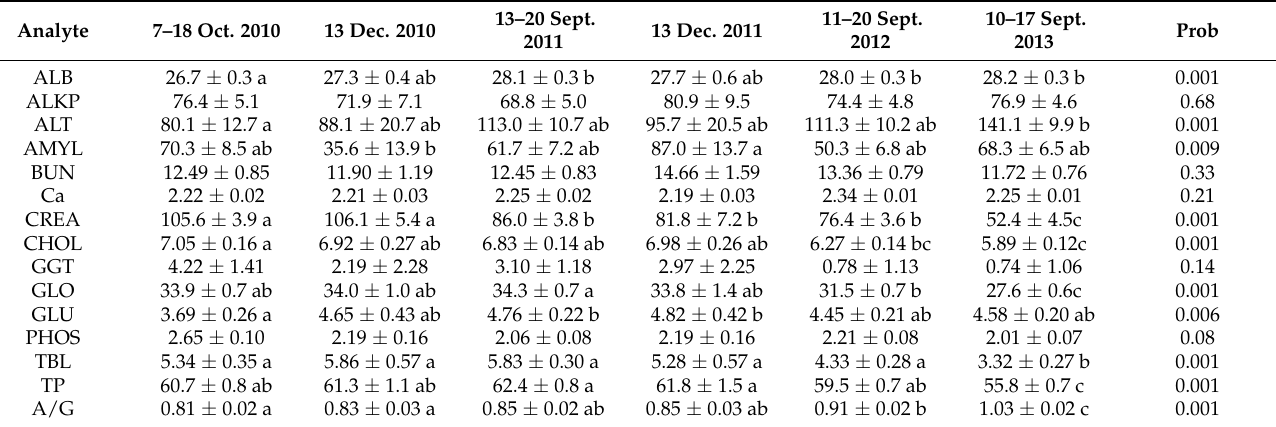
Table 7. Least-squares means ± standard errors of the original serum analytes by inoculation dates §